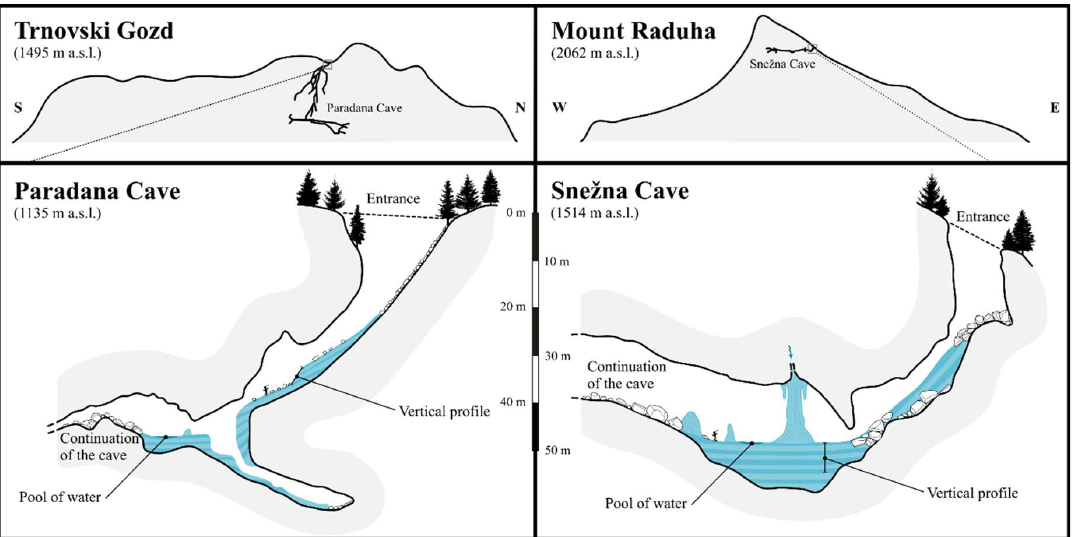
Figure 2. Cross sections of the studied caves showing the location of the ice in the entrance part of the Paradana Cave and Snežna Cave and the location of vertical profiles and pools of water where sampling took place are shown on the upper figures. Cross sections of the entire caves and position within the topography of Trnovski Gozd karst plateau and Mount Raduha and boxes indicating the location of the profiles are shown in the upper figures (cartography by Jure Tičar).